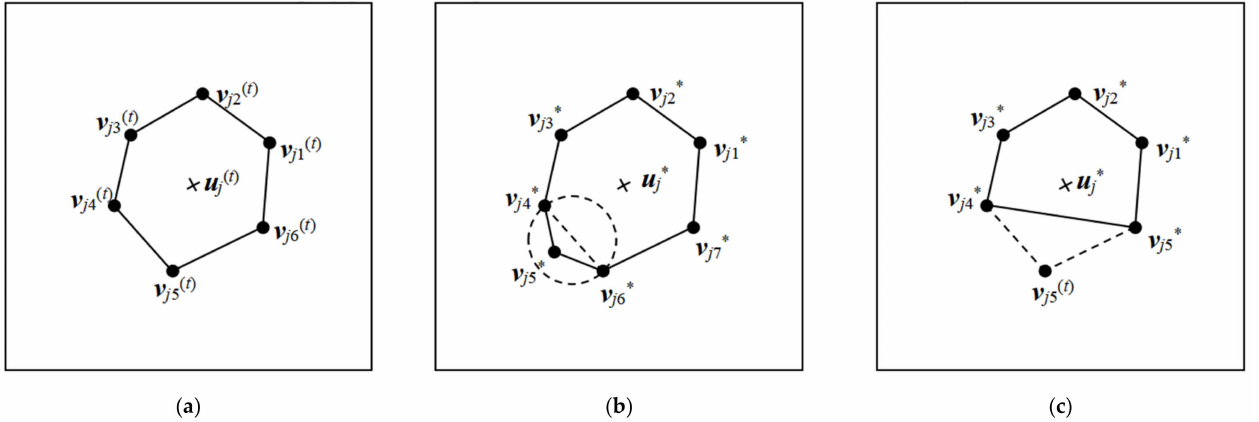
Figure 3. The examples of adding and deleting a polygon node: ( a ) Configuration w ( t ) of object; ( b ) Add a polygon node; ( c ) Delete a polygon